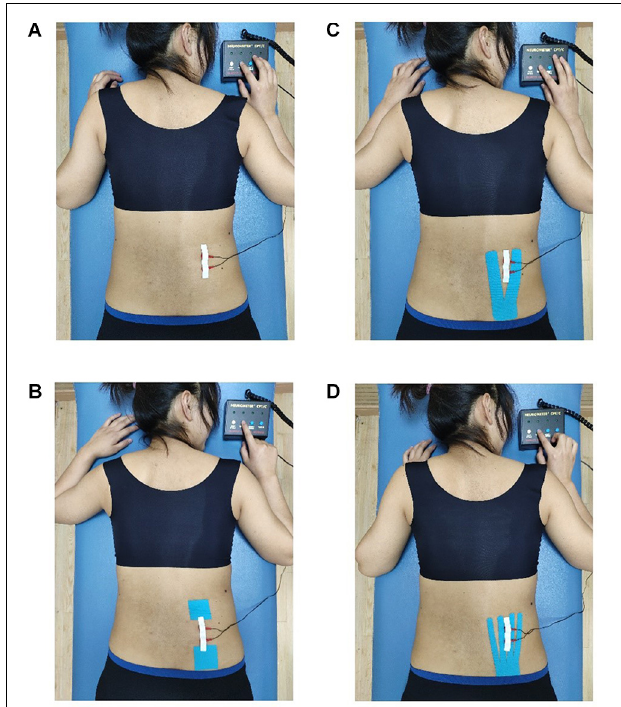
FIGURE 1 | Different taping methods with the CPT test. (A) No taping, (B) placebo taping, (C) Y-strip of Kinesio taping, and (D) fan-strip of Kinesio